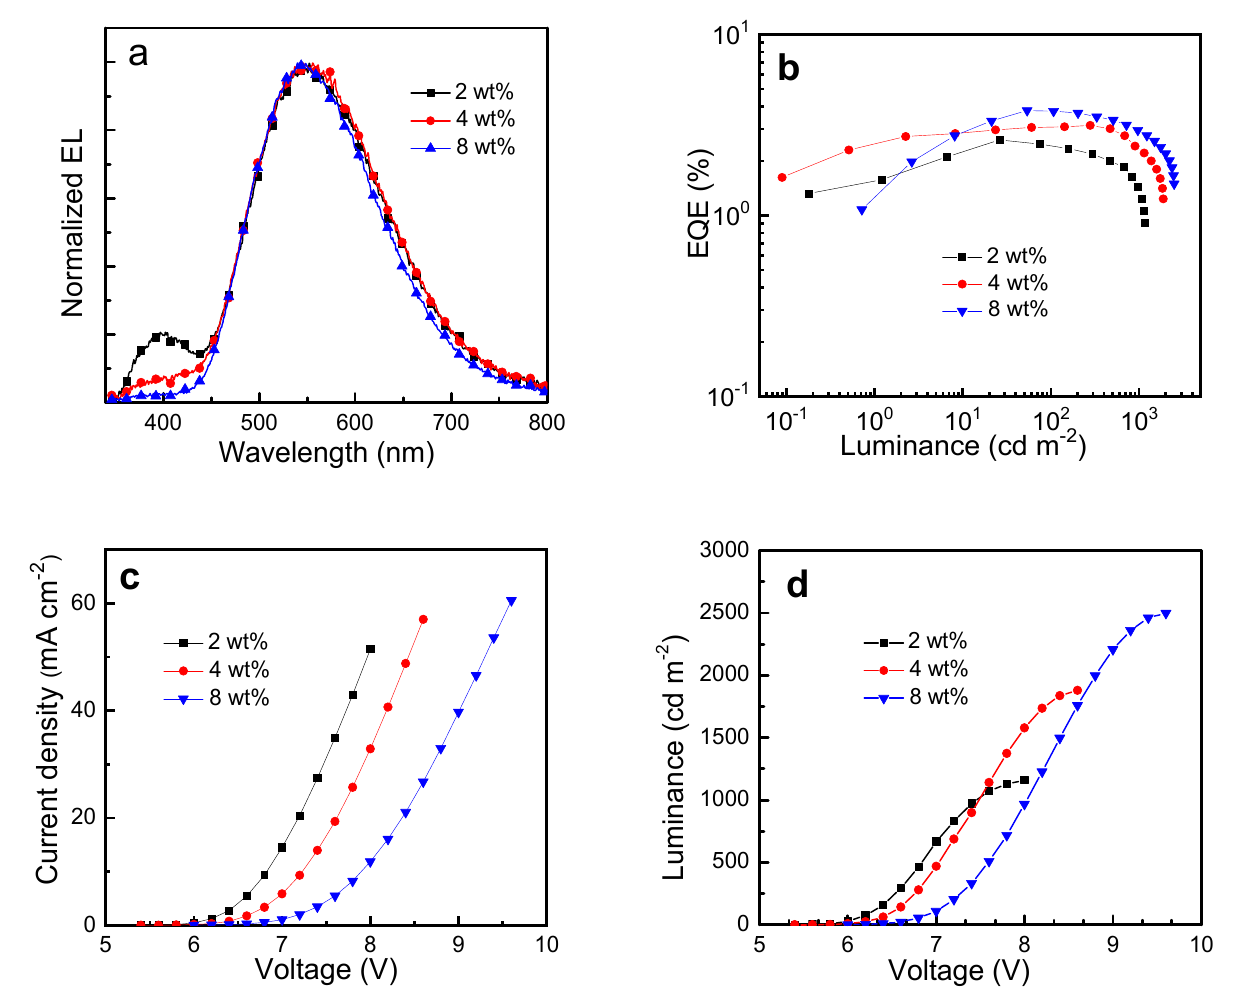
Figure 3. Characteristics of solution-processed devices according to Figure 2 based on Cu 2 Cl 2 (P ∩ N) 2 luminescent com- pounds with concentrations of 2, 4, and 8 wt % in PYD2 host films. ( a ) Normalized EL spectra at 1000 cd m − 2 , ( b ) EQE vs. luminance ( c ) current density vs. voltage, and ( d ) luminance vs. voltage characteristics.